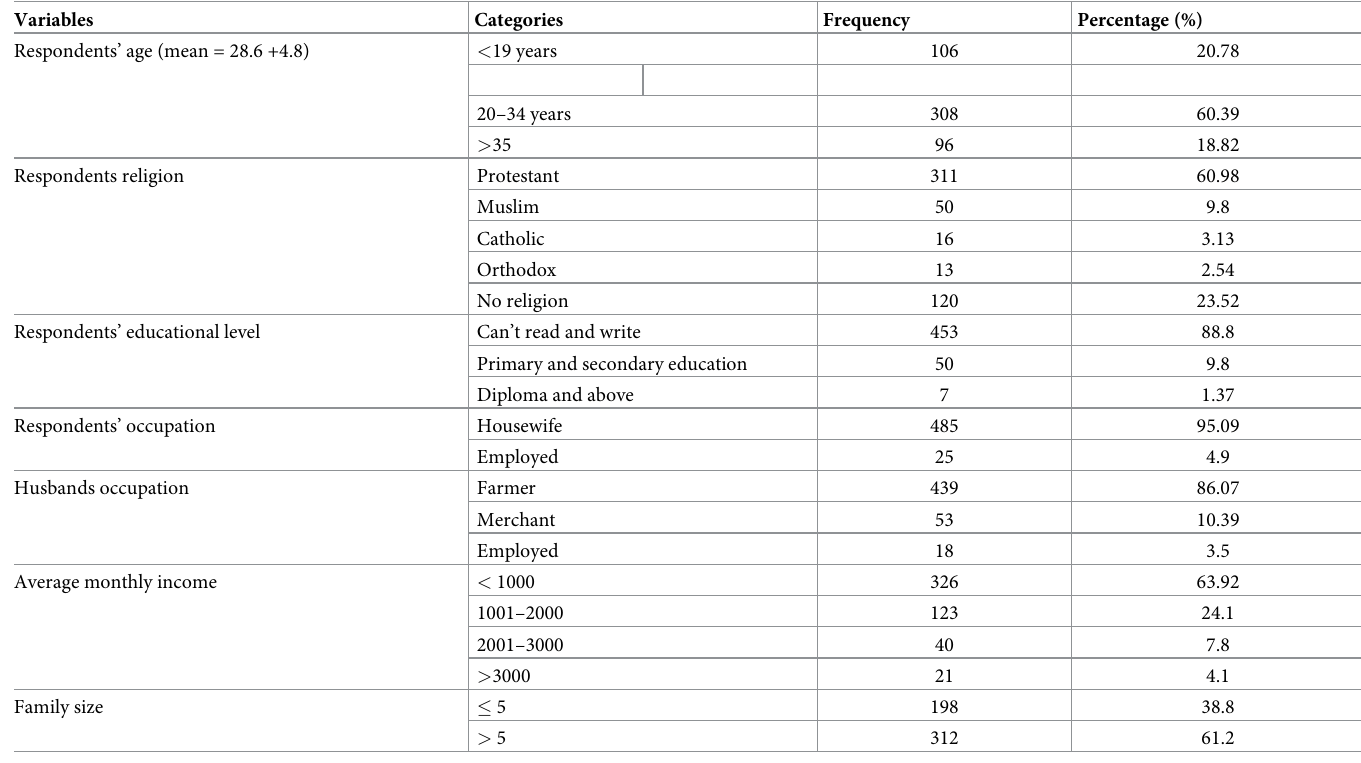
Table 1. Respondents’ socio-demographic characteristics in the Kambata-Temabaro Zone, Southern Ethiopia, 2019 [n = 510]. Variables Categories Frequency Percentage (%) Respondents’ age (mean = 28.6 +4.8) < 19